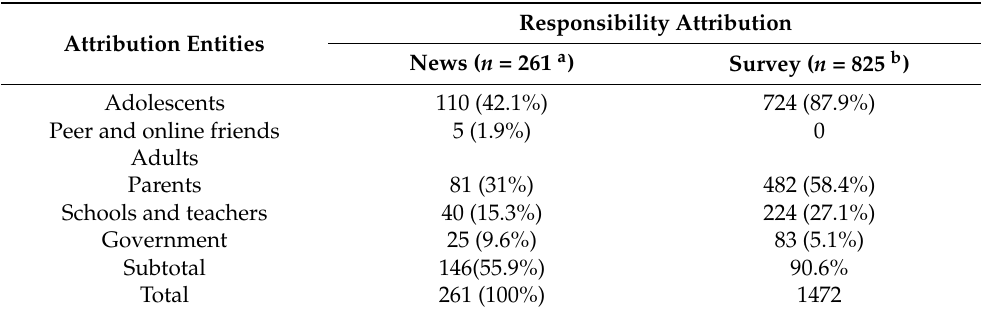
Table 2. Comparison of percentage of agencies viewed responsible for youths’ risks and opportunities on social media.